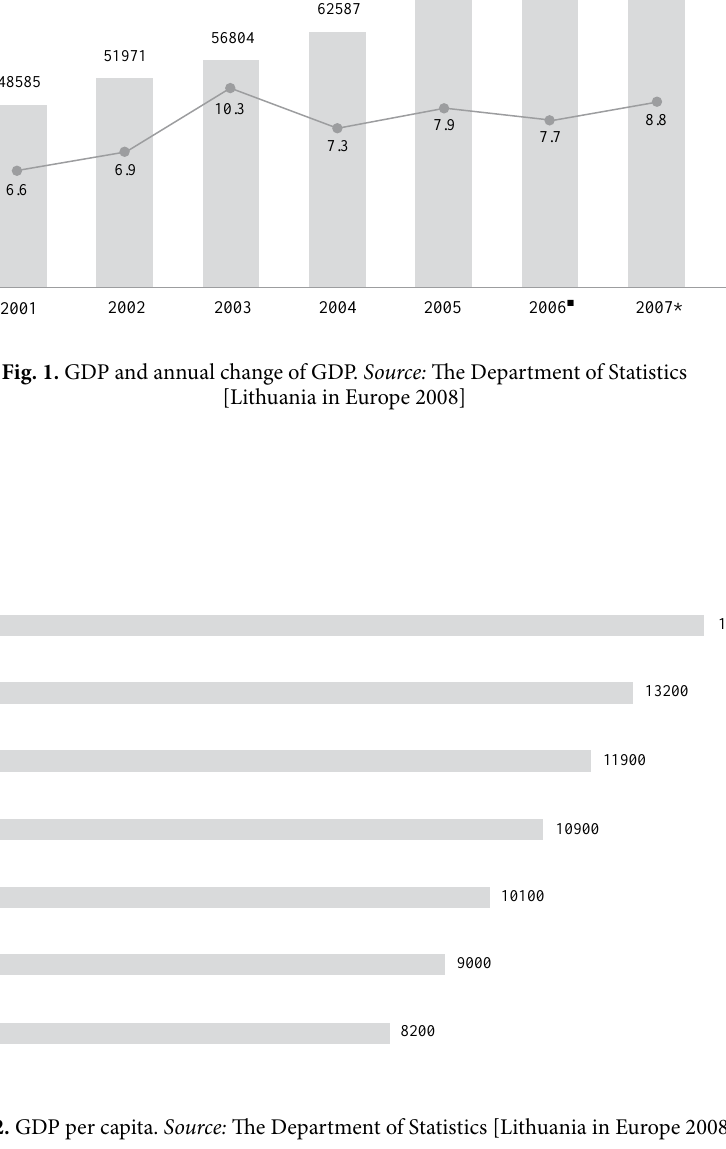
GDP, at current prices, LTL